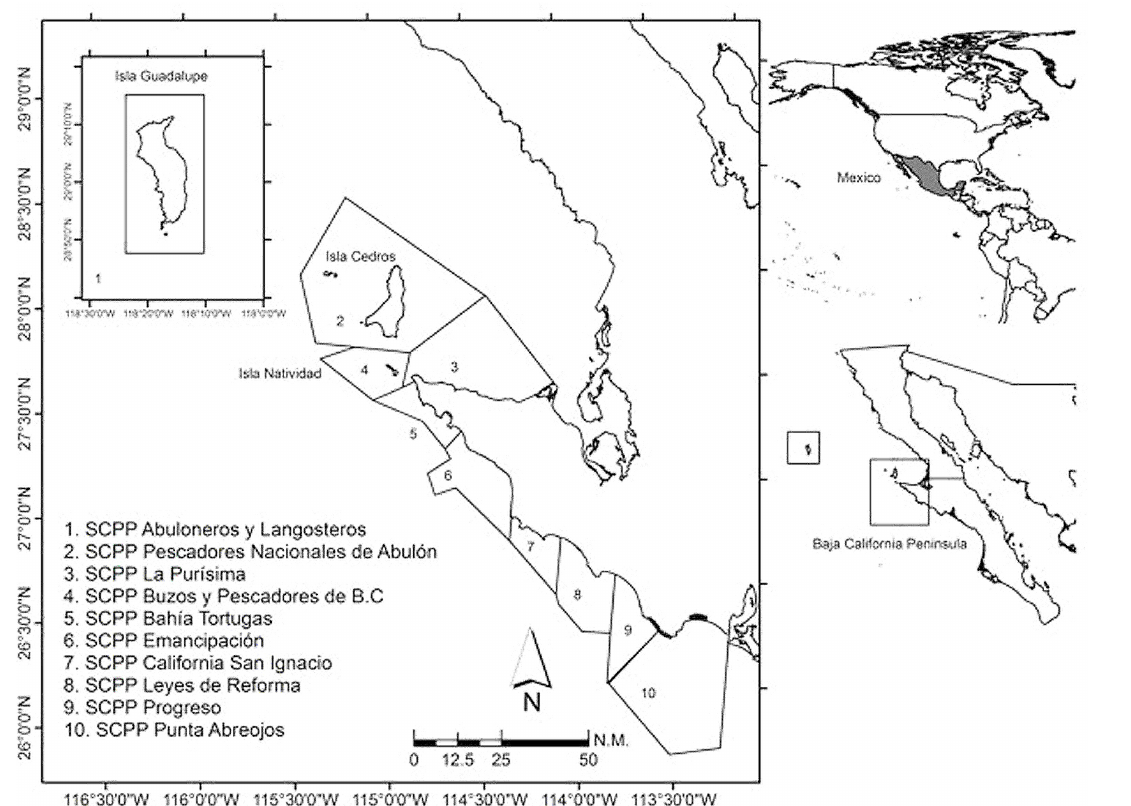
Fig. 1 . Map of the concessions of the fishery cooperative societies (Sociedades Cooperativas de Producción Pesquera, SCPP) of the Vizcaino region, Baja California and Baja California Sur, Mexico. Courtesy